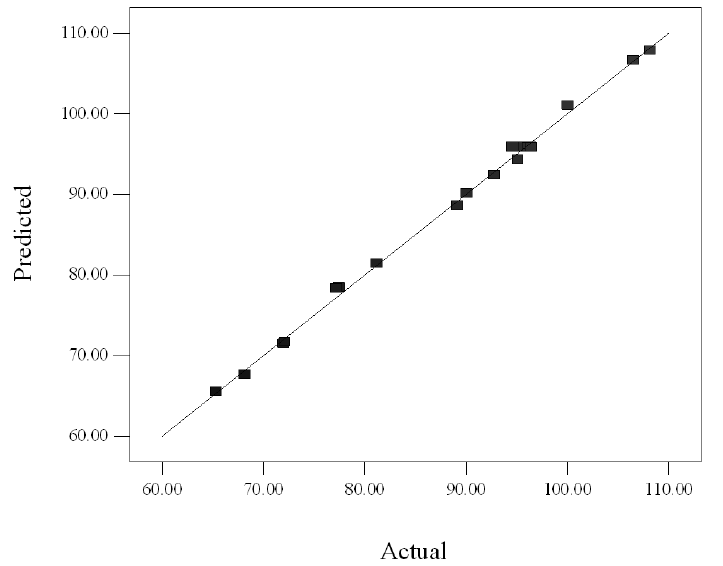
Figure 2. Plot of predicted crude extract yield related with experimental